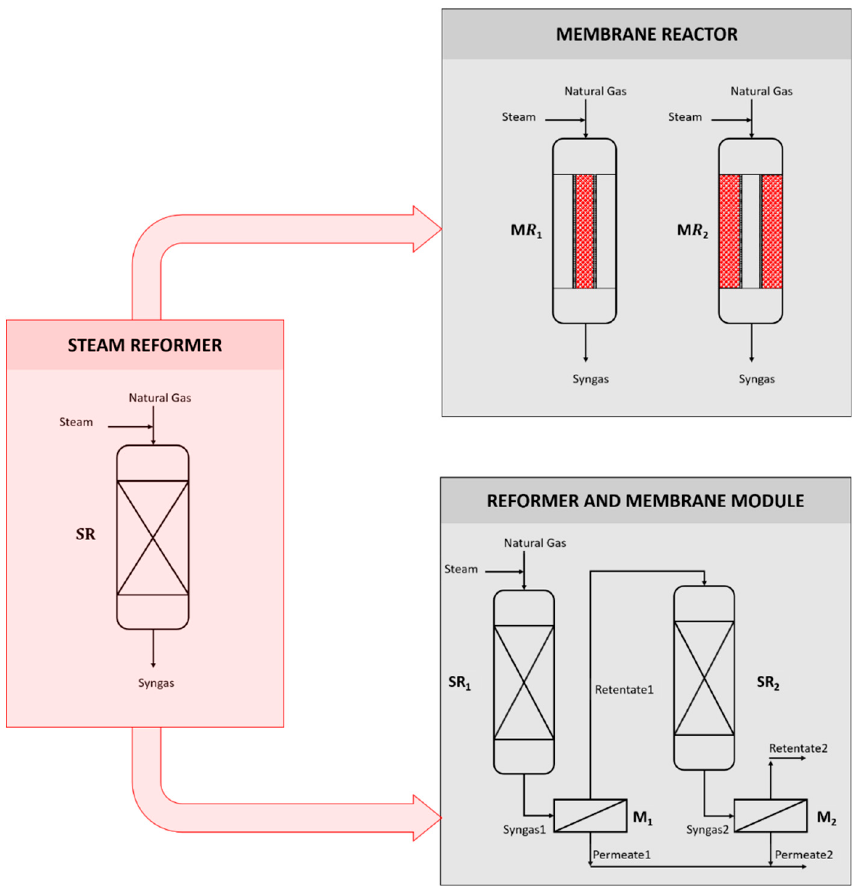
Figure 1. Schematic representation of steam reformer (SR), membrane reactor (MR), and reformer and membrane module (RMM).